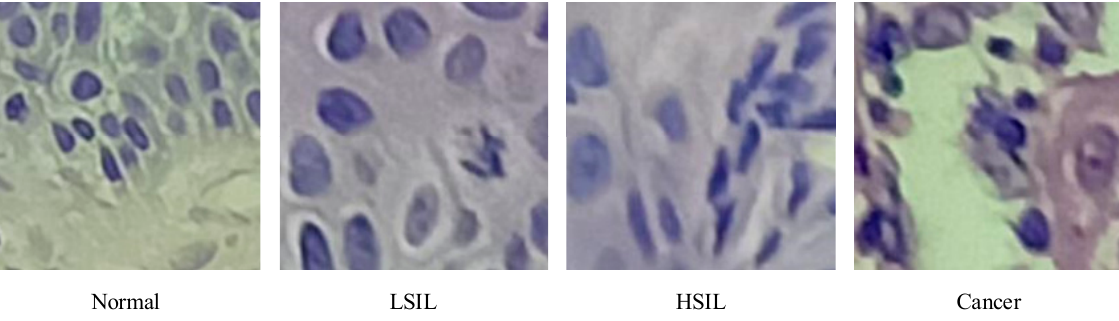
Figure 2. Small-size cervical tissue biopsy image, each with a resolution of 200 × 200 (RGB) pixels.